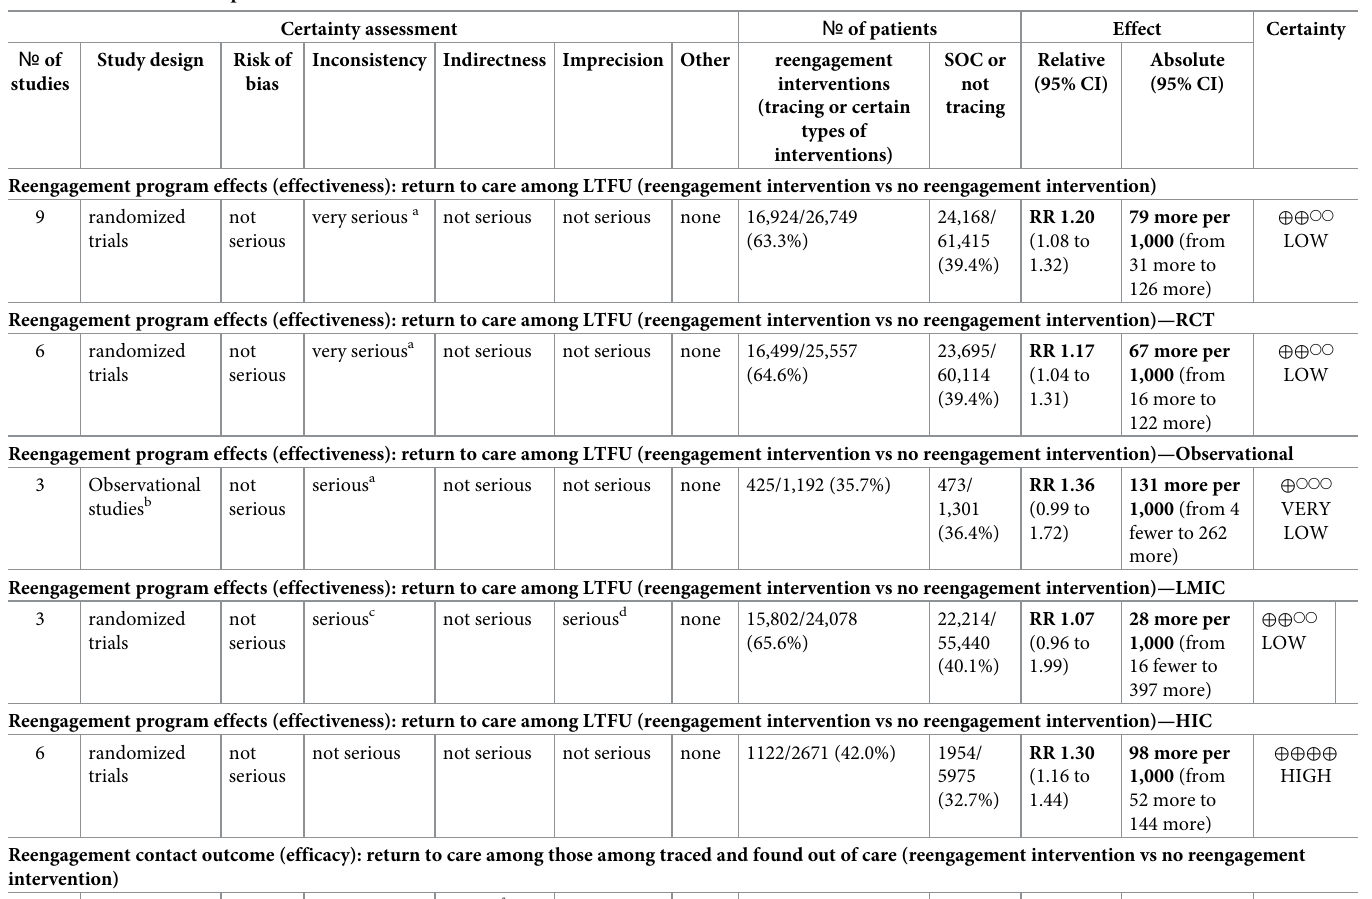
Table 7. GRADE evidence